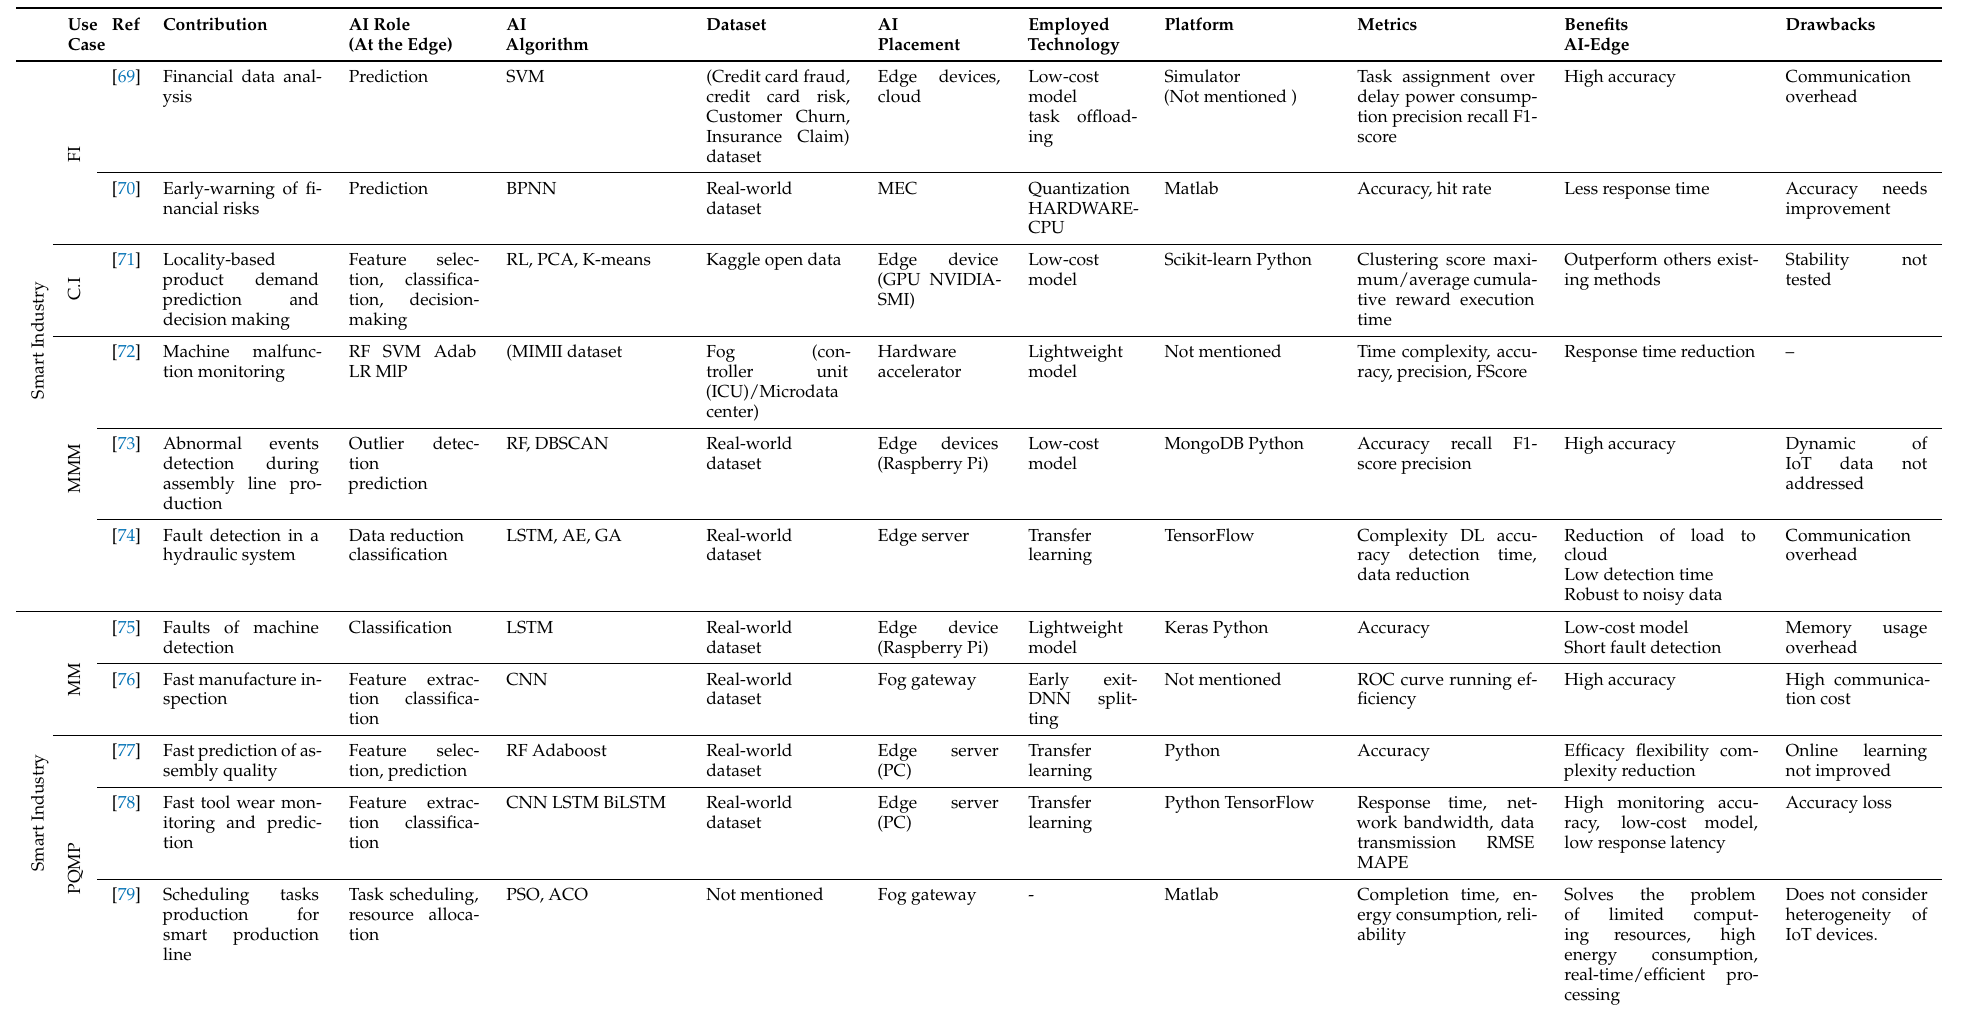
Table 7. Qualitative comparison of smart industry related